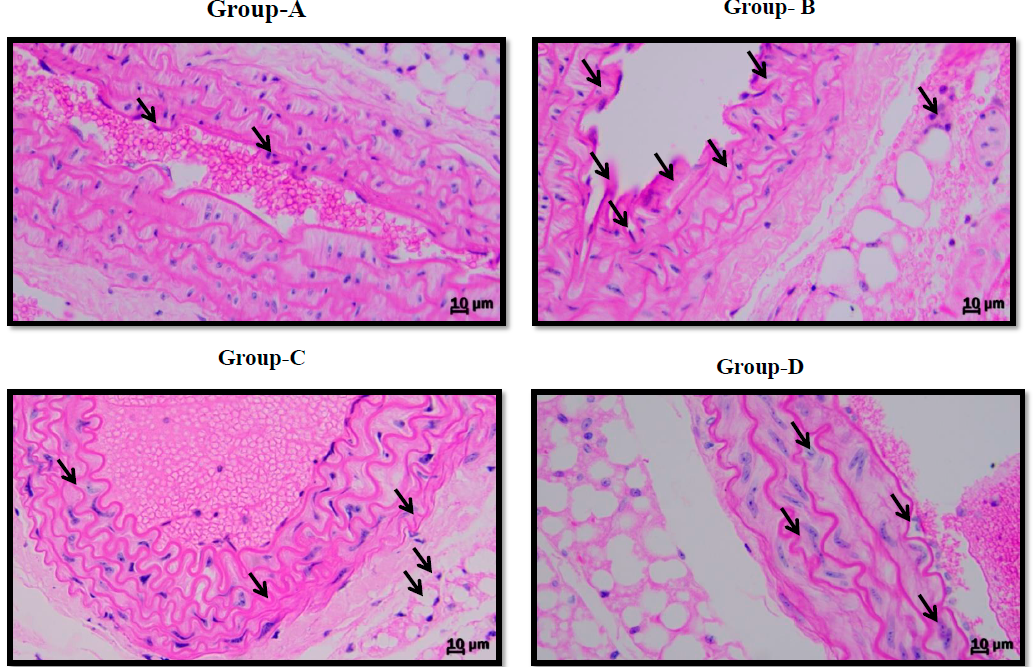
Figure 3. Aortic representative slices (5 μ m-thick) stained with H&E. ( A ) Control group. ( B ) Endo- thelial cells in LPS-induced mice had significant damage, including disordered organization, indistinct borderlines, and partial deletion (arrow). ( C ) LPS + SRP-treated mice, who suffered less damage than LPS-treated mice. ( D ) LPS+AT-treated mice, who suffered less damage than LPS mice. Scale bars indicate 10 μ m. (n = 6). Original magnifications—100×.